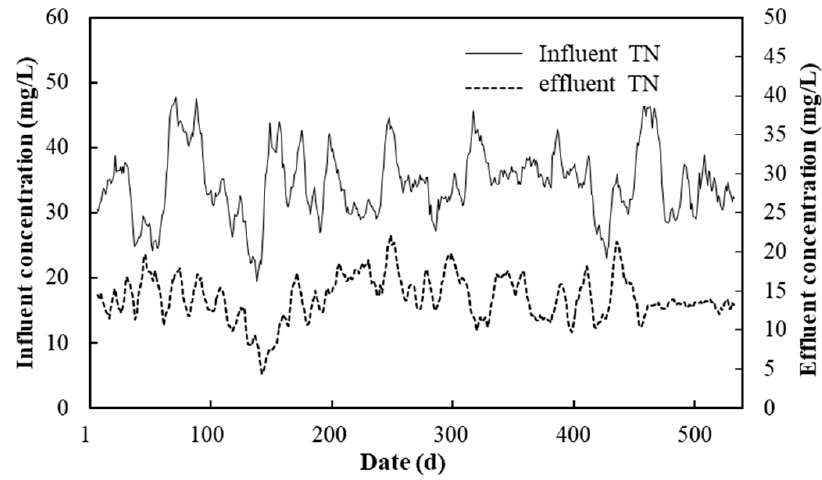
Figure 3. Influent and effluent of total nitrogen in the CAST process (discharge standard: 15.0 mg/L).